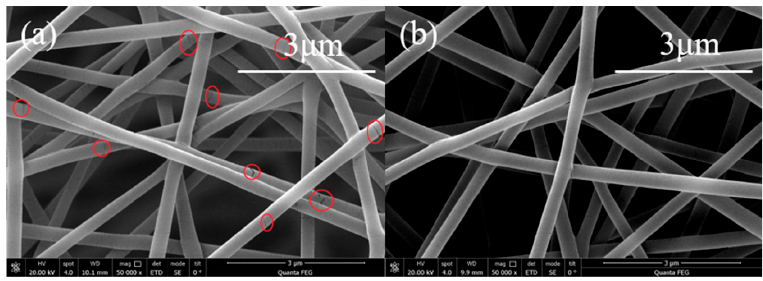
Figure 6. ( a ) PVA electrospinning nanofiber film and ( b ) PVA/CNTs composite nanofiber film.